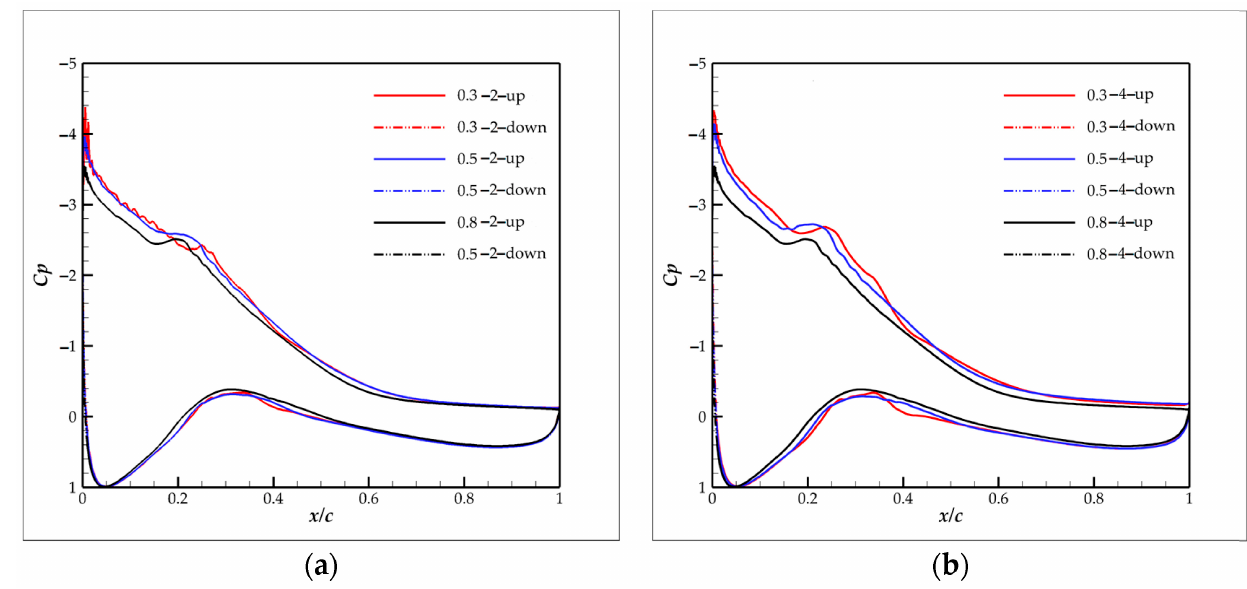
Figure 18. Pressure distribution of aerodynamic repair models with different repair widths at α = 14 ◦ : ( a ) RH = 2 mm; ( b ) RH = 4